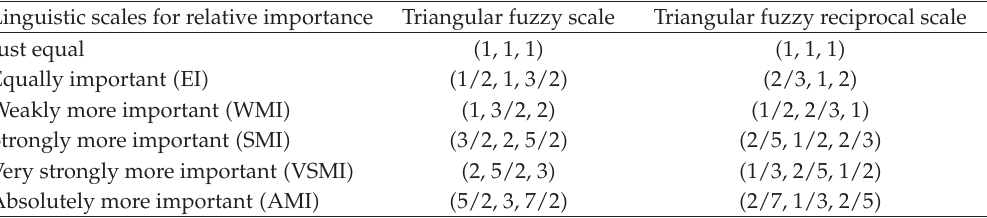
Table 1: Linguistic scales for